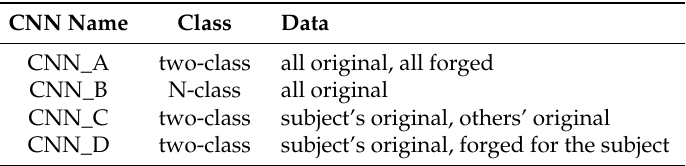
Table 1. CNN feature extractors’ data set.